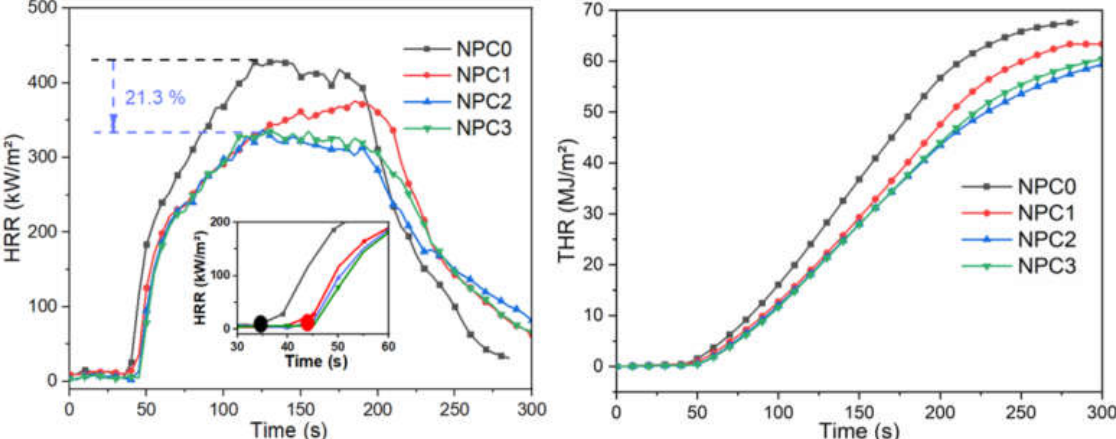
Figure 9. Curves of HRR and THR vs. time from cone calorimeter test for PLA-based NPCs.